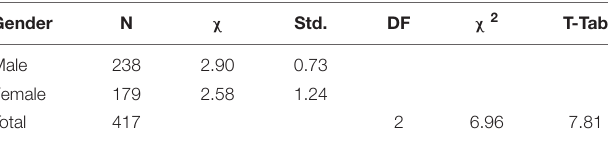
TABLE 2 | Chi-square statistic for class organization and Students’ self-identity and self-esteem. Gender